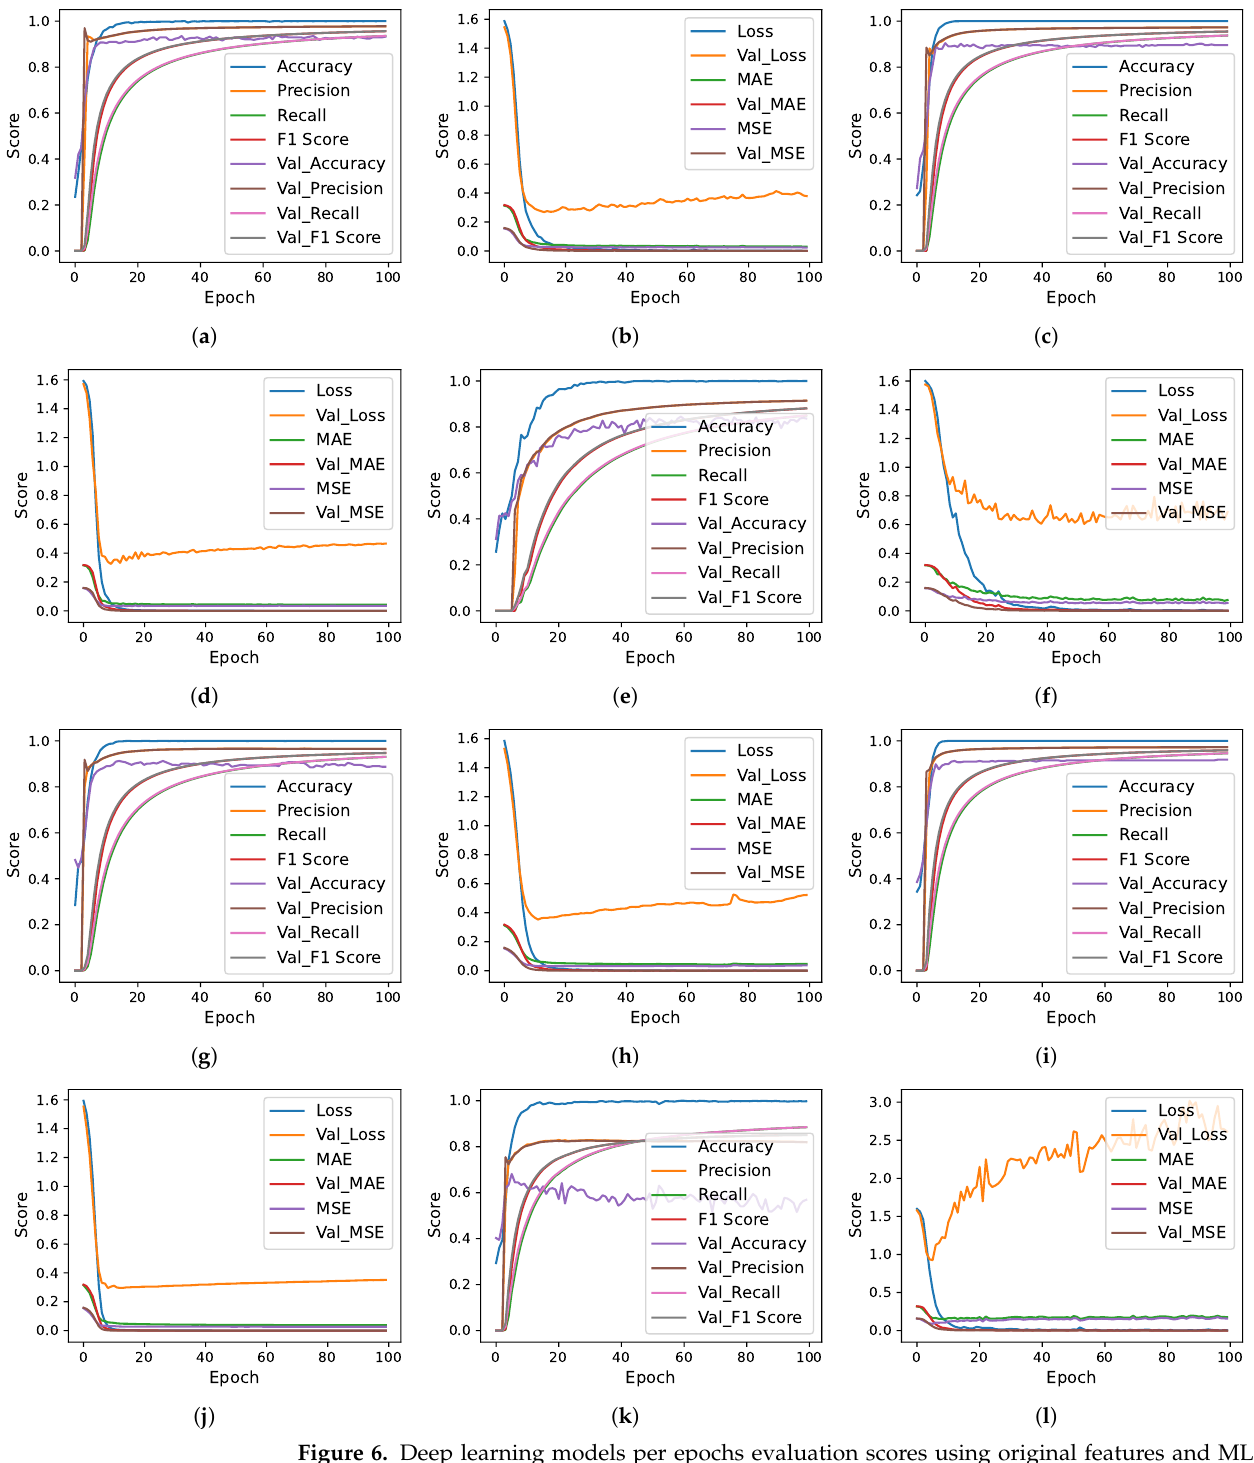
Figure 6. Deep learning models per epochs evaluation scores using original features and